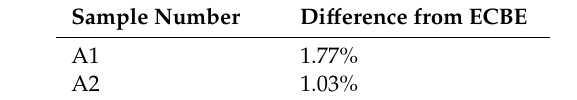
Table 7. The estimation di ff erence of Lithium Cobalt Oxide (LCO) batteries.